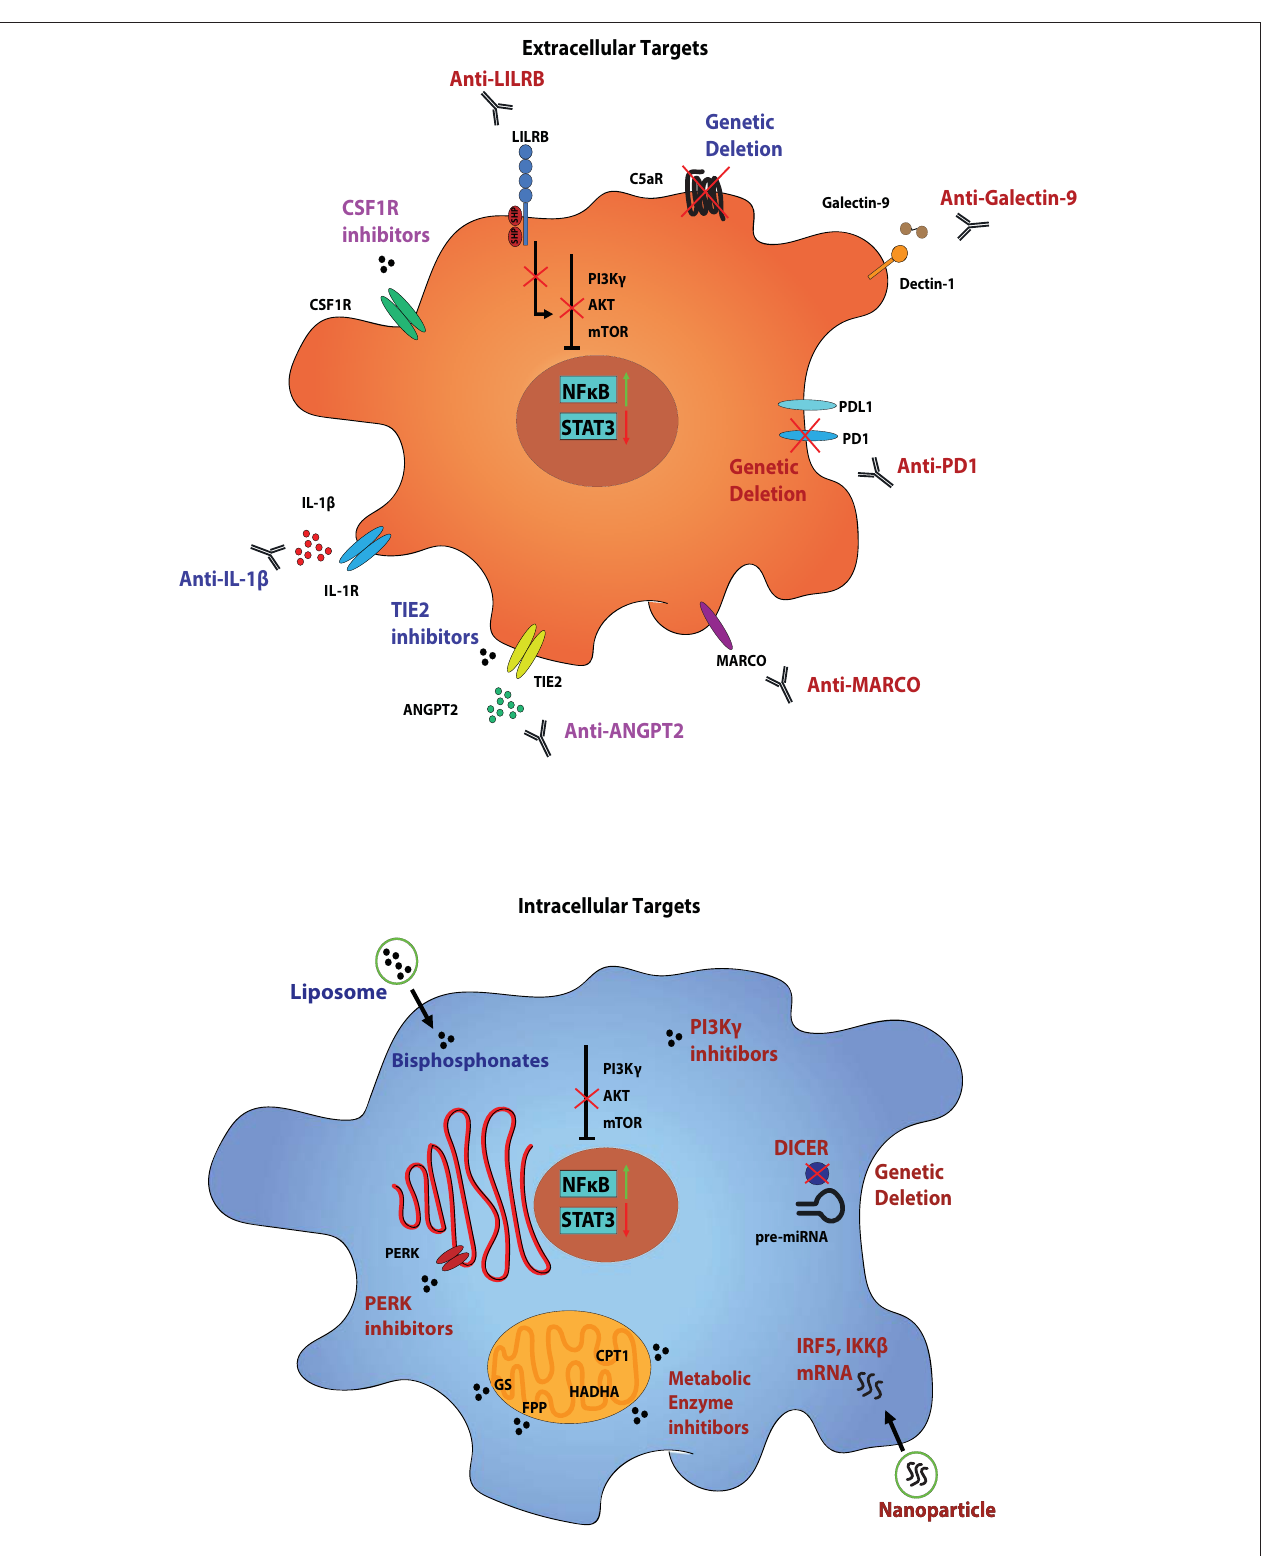
FIGURE 1 | Myeloid cell populations within the TIME and strategies to target them. Tumor-infiltrating myeloid cells, such as MDSCs and TAMs, perform a variety of functions in order to keep the TIME a hospitable niche for tumor growth and progression. Mechanisms include direct secretion of growth factors to support the viability of the tumor, in addition to maintaining an immunosuppressive environment to prevent recognition by cytotoxic immune cells. These functional states are controlled by